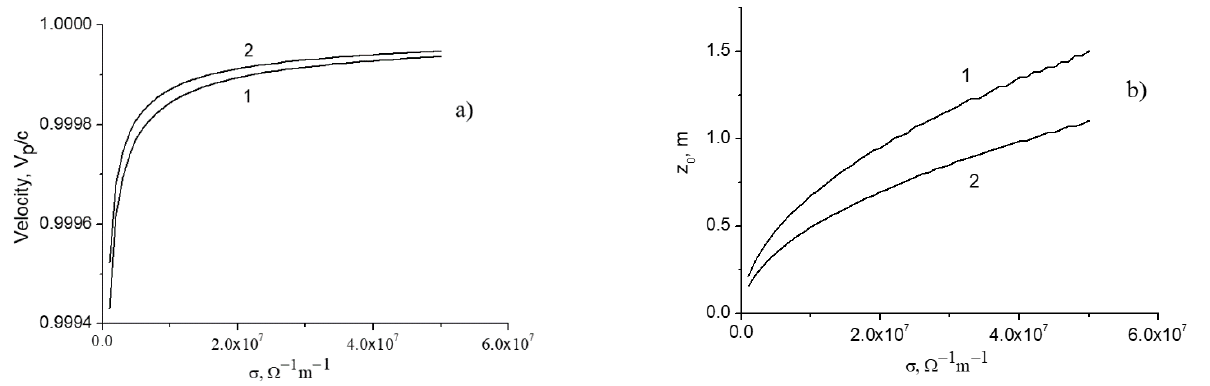
Figure 3. The phase velocity ( a ) and attenuation length ( b ) as function of conductivity. 1 − 𝜔 = 0.9 THz, 2 − 𝜔 = 1.1 THz. 2— ω = 1.1